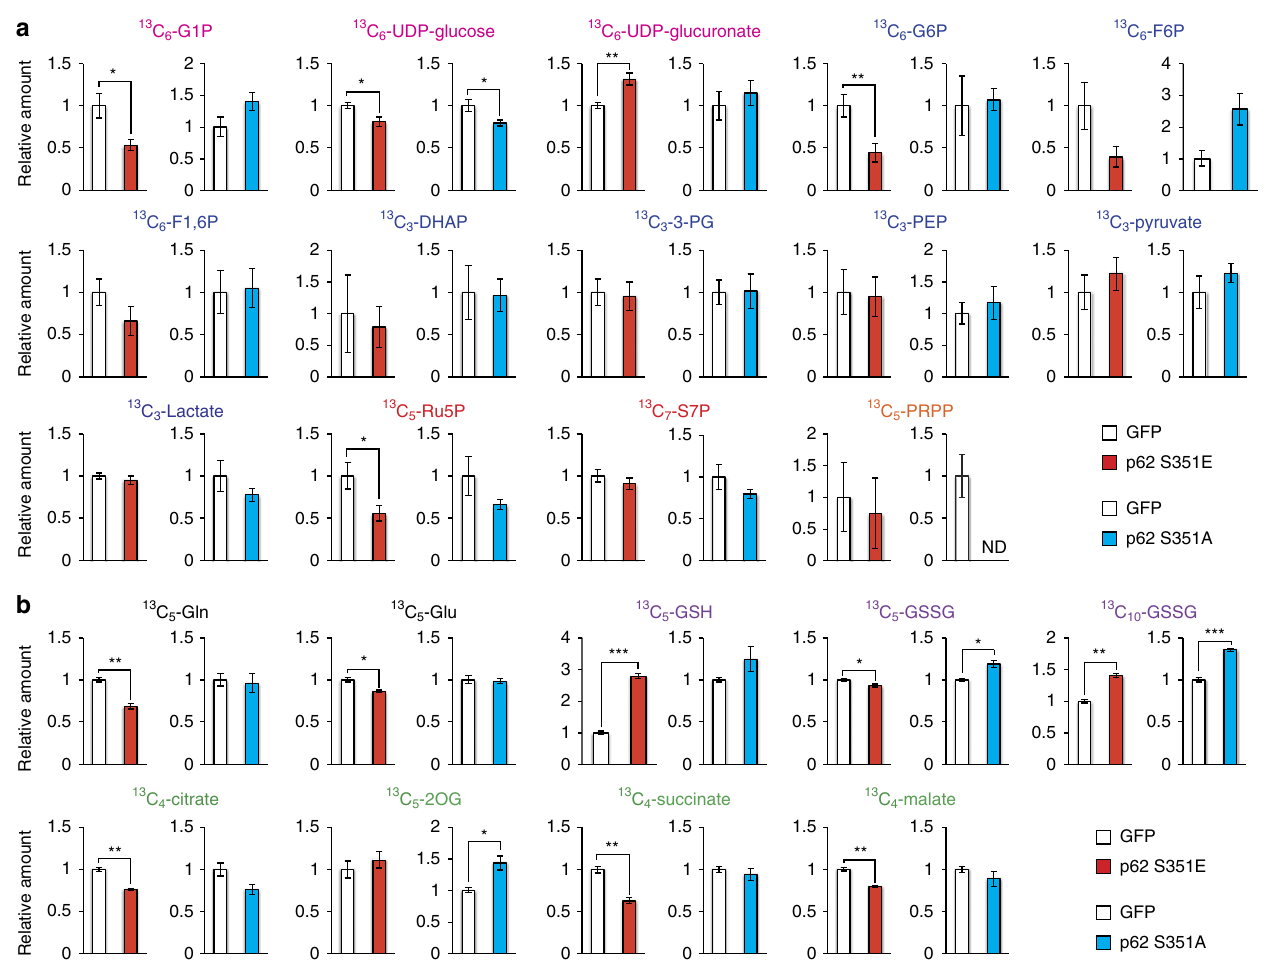
Figure 4 | Glucose and glutamine metabolism in HCC cells harbouring phospho-mimetic p62. ( a ) Tracer study using [U- 13 C 6 ] glucose. Huh7 cells expressing GFP, S351E or S351A were incubated with [U 13 C 6 ] glucose for 1h and analysed. The experiments were performed ten times. Data are presented as means ± s.e. * P o 0.05, ** P o 0.01, *** P o 0.001 as determined by the Welch t -test. ( b ) Tracer study using [U- 13 C 5 ] glutamine. Huh7 cells expressing GFP, S351E or S351A were incubated with [U- 13 C 5 ] glutamine for 6h and analysed. The experiments were performed three times. Data are presented as means ± s.e. * P o 0.05, ** P o 0.01, *** P o 0.001 as determined by the Welch t -test. We used mouse p62 constructs in these